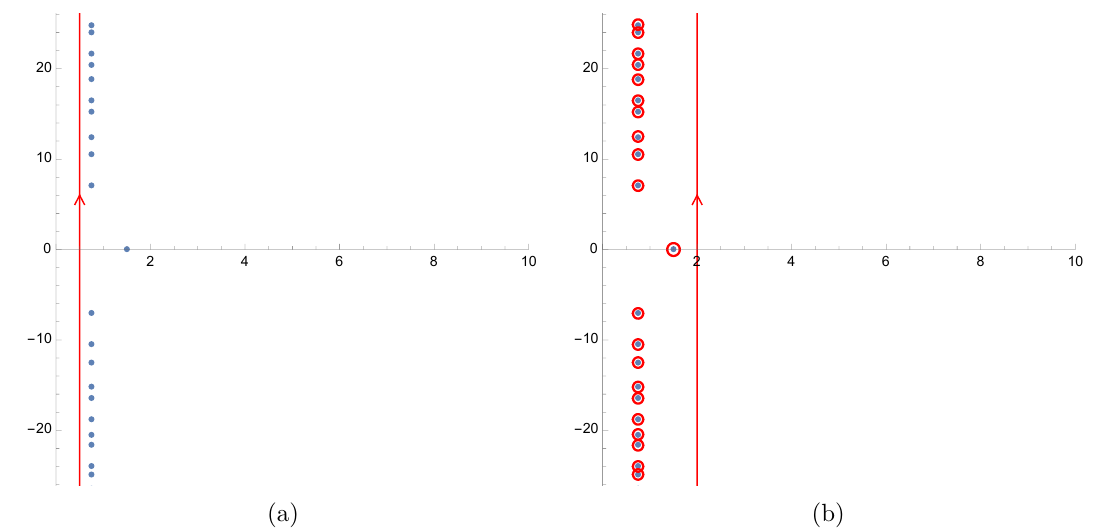
Figure 1 . (a) Pole structure of the integral in (3.11) in the complex s plane. The poles are located ∗ at s = c (shown here for c = 3 ), where z , 1+ z n , 1+ z n 2 2 2 function with positive imaginary part. If the Riemann hypothesis is true, the tower of poles in the figure all occur at real part 3 , except for the pole at s = c 4 to Re ( s ) > c 2